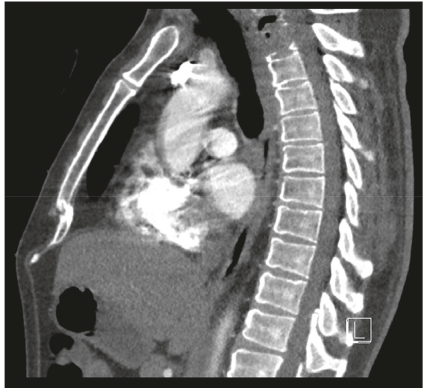
Figure 3: CT spine demonstrating local invasion of the tumor and air within the vertebral bodies.